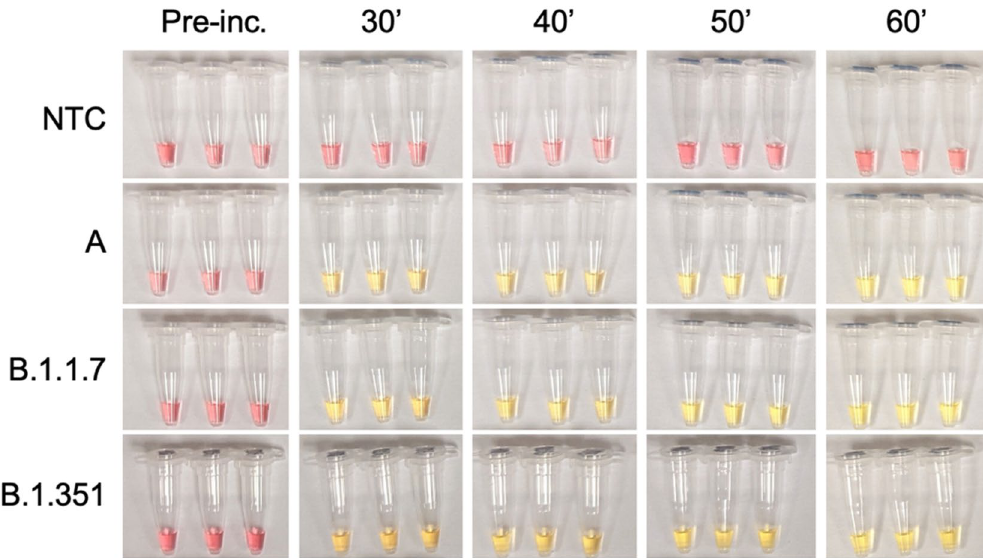
Figure 3. Validation of the RT-LAMP home test on heat inactivated SARS-CoV-2 variants (calculated viral copy numbers per tube indicated): A (WA-1/2020; 4.86 × 10^4), B.1.1.7 (1.51 × 10^5), and B.1.351 (4.79 × 10^5). Heat-inactivated virus was diluted in nuclease-free water. Viral copy numbers were calculated following quantification of stocks. Methods otherwise as described previously. NTC: non-template control (nuclease-free